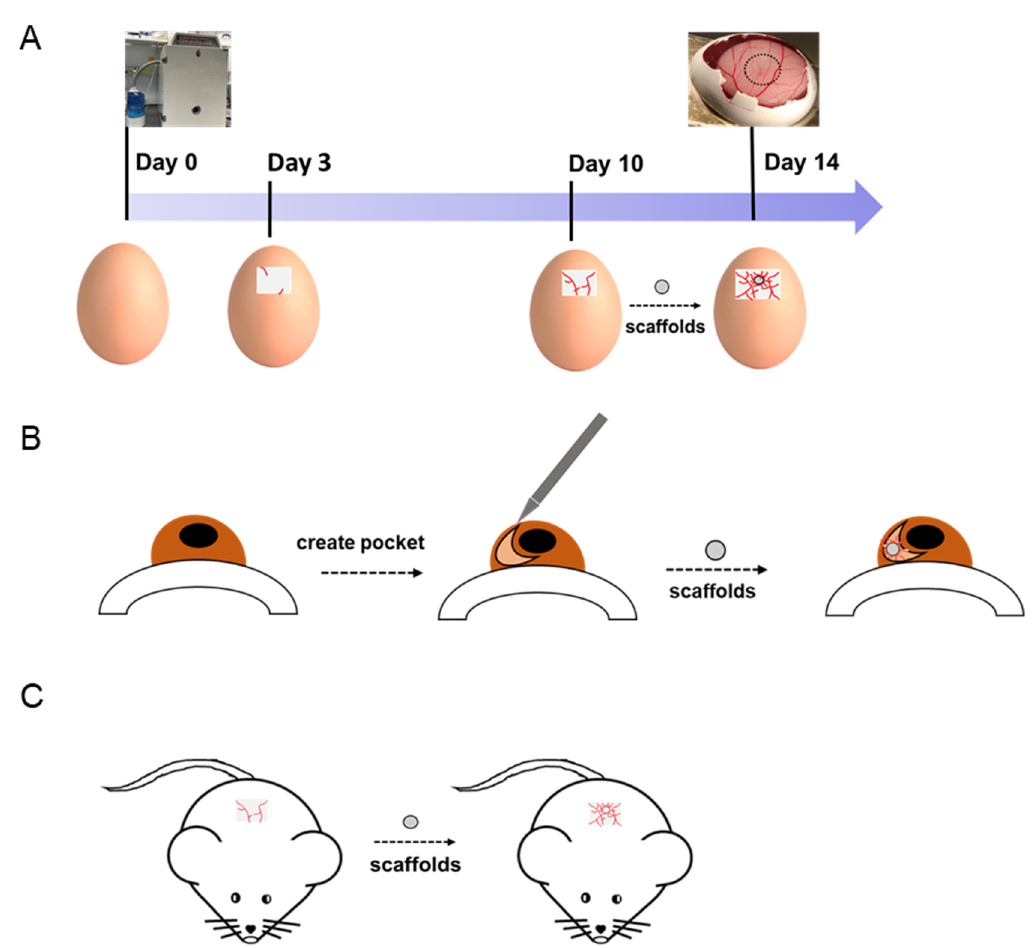
Figure 7. ( A ) Chick chorioallantoic membrane (CAM), ( B ) rabbit cornea, and ( C ) mouse models are used to evaluate the angiogenic abilities of implanted scaffolds.